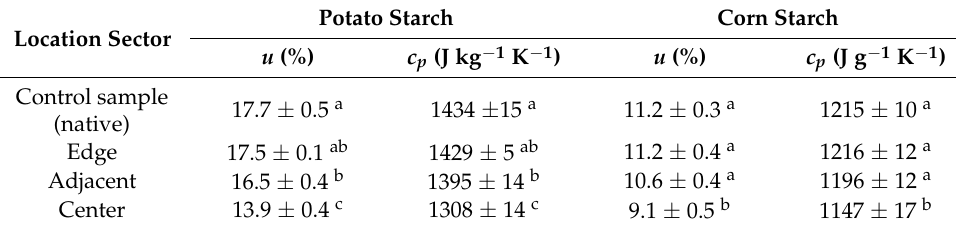
Table 2. Values of the moisture content ( u %) and specific heat capacity ( c p ) for studied starches. Potato Starch Corn Starch Location Sector Control sample (native)